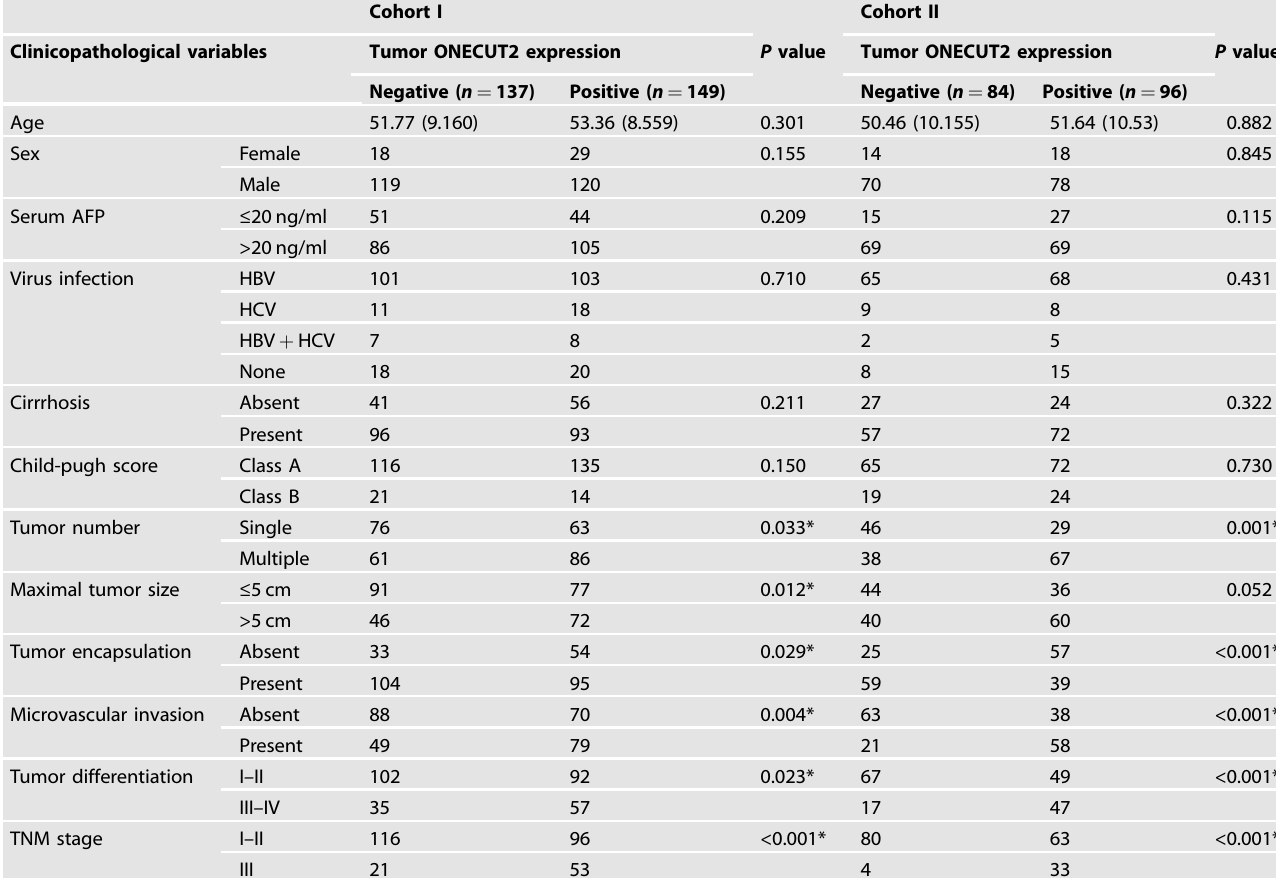
Table 1. Correlation between ONECUT2 expression and clinicopathological characteristics of HCCs in two independent cohorts of human HCC